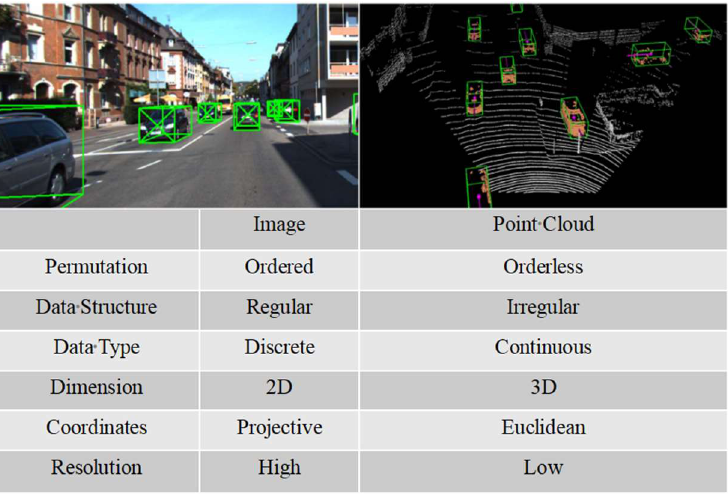
Figure 5. A comparison between image data and point cloud